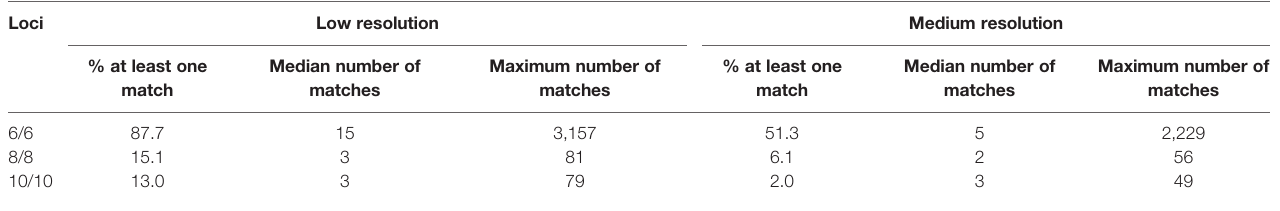
TABLE 2 | Proportion of individuals with at least one match in Brazilian Bone Marrow Donor Registry (REDOME), median number of matches and the maximum number of matches at low and medium resolution. Loci Low